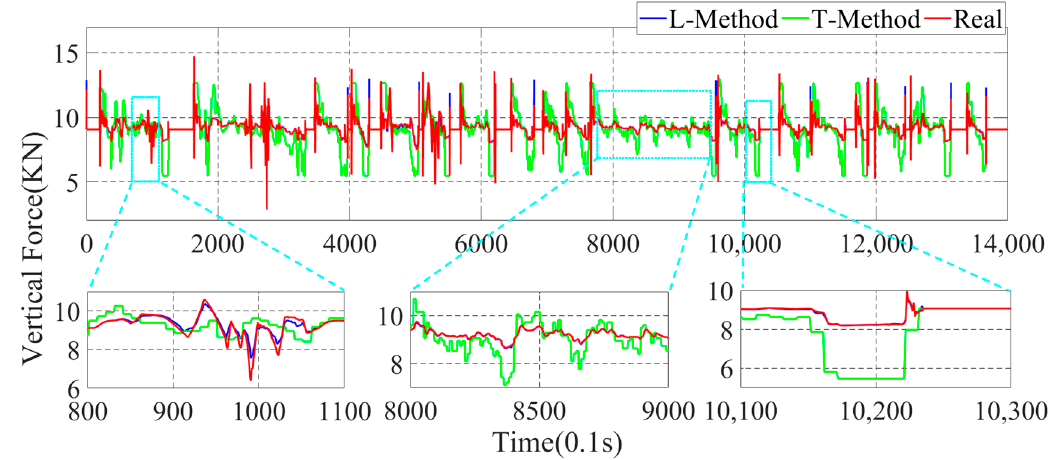
Figure 11. Parameter estimation of the left-rear wheel vertical force of the vehicle.